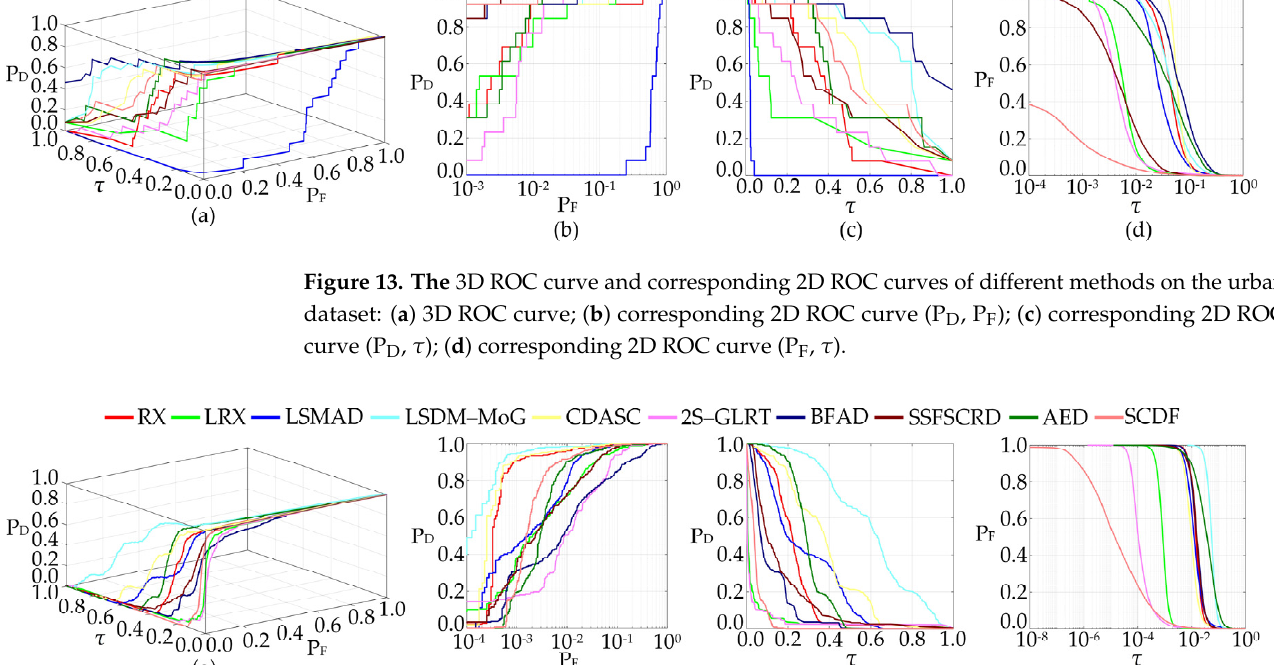
Table 2. Comparison of AUC performance of different methods on the synthetic dataset.